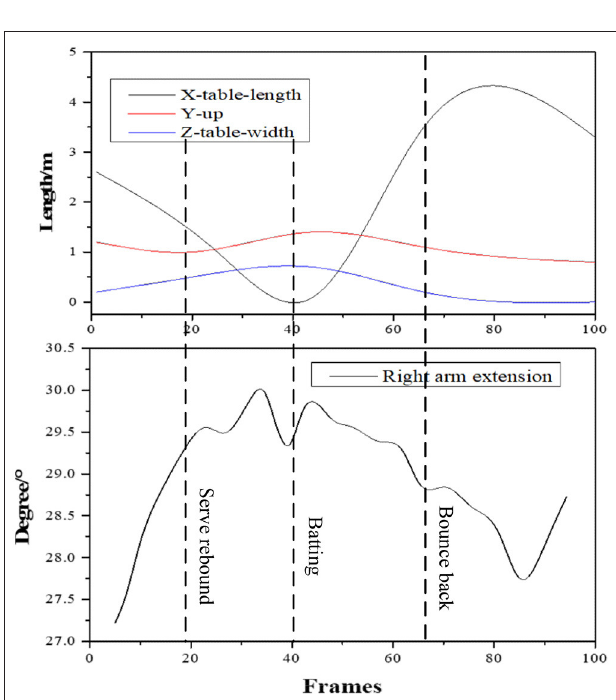
FIGURE 11 | Comparison of the ball trajectory and right arm extension motion detection of athletes during the same round.